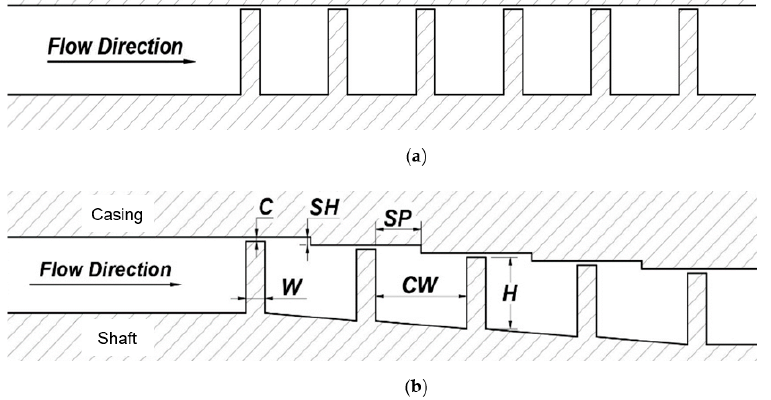
Figure 1. Labyrinth seal geometrical sketch and parameters. ( a ) Straight-through seal ( b ) Stepped seal.